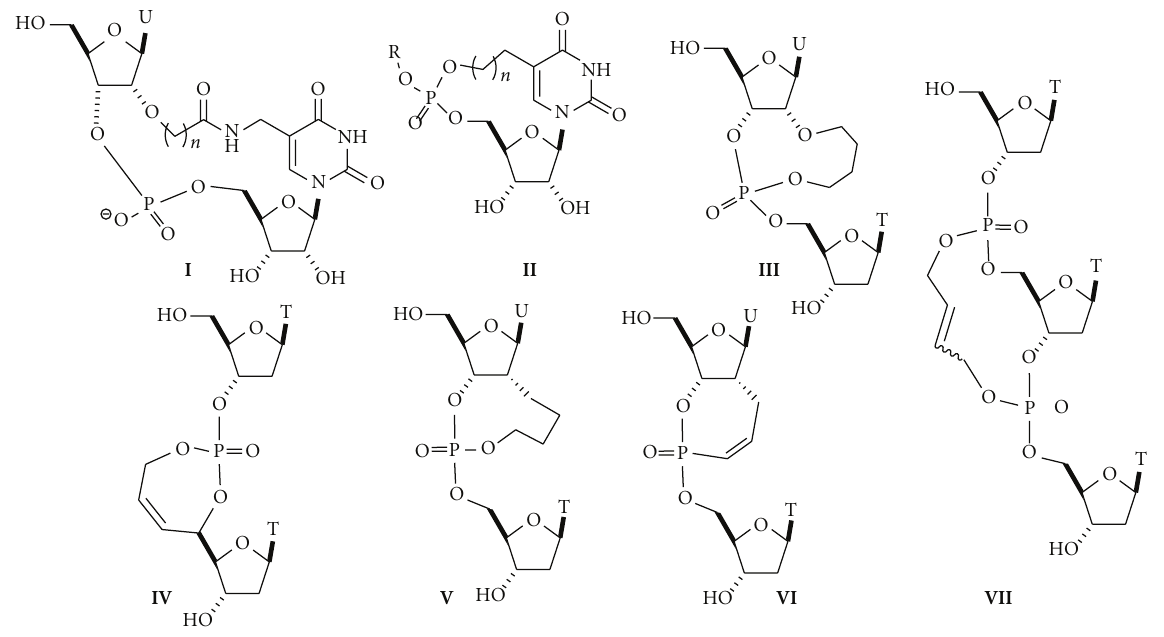
Figure 2: Selected macrocyclic-constrained